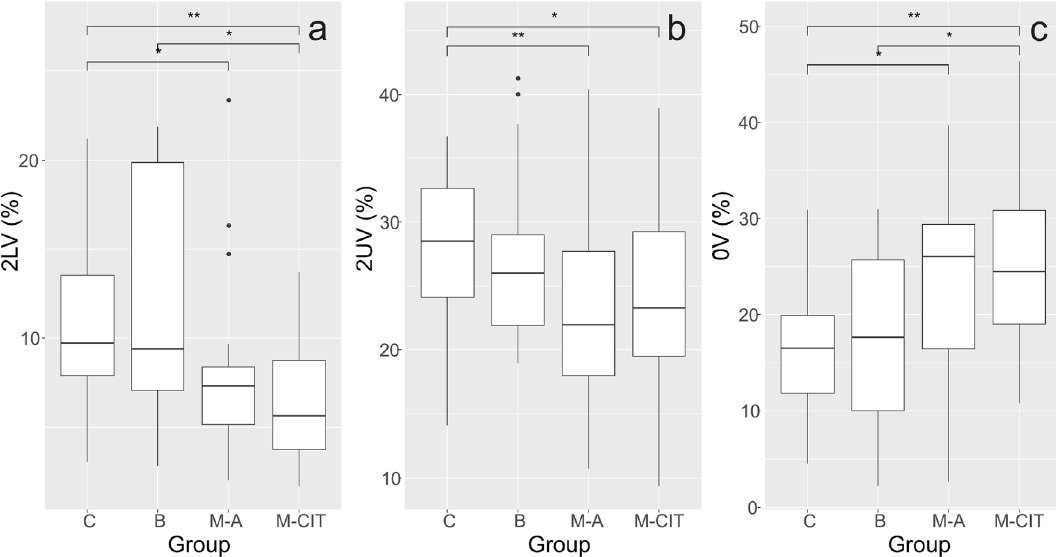
Figure 2. Intergroup comparison of the 2LV (%) ( a ), 2UV (%) ( b ) and 0V (%) ( c ) parameter. Brackets indicate significant differences between groups [*p < 0.05, **p < 0.01; Kruskal–Wallis test, LSD for ( c )]. C control group, B benign tumor, M-A survivors with active cancer, M-CIT survivors after completed initial